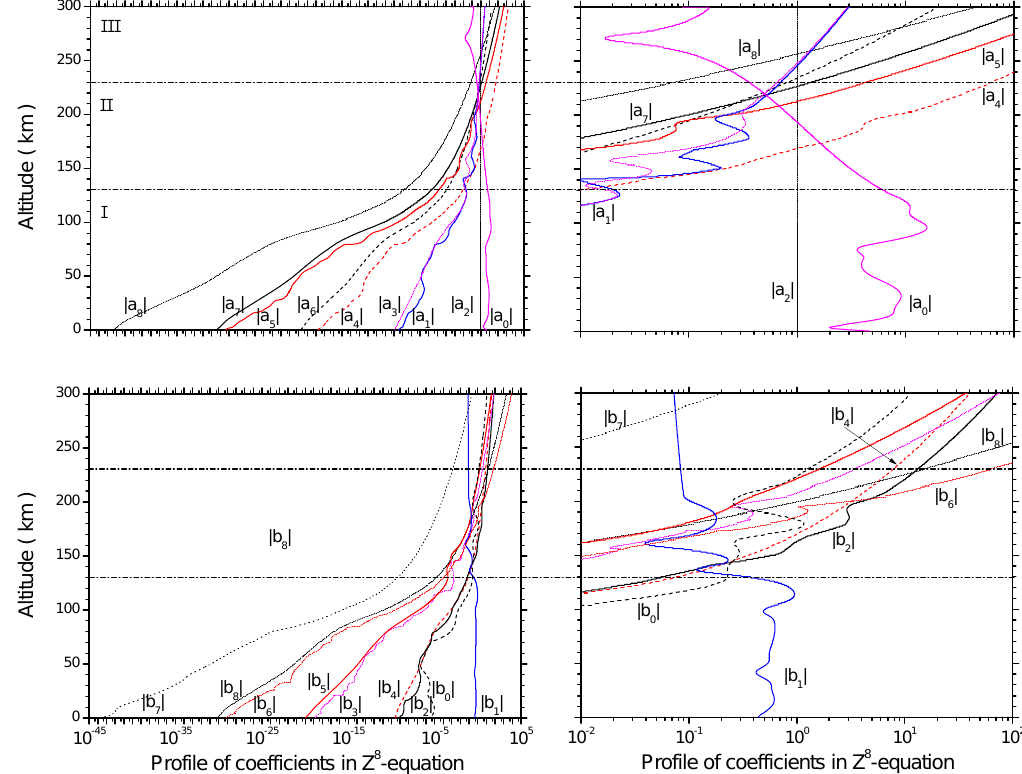
Figure 3. Vertical profiles of coefficients a 0 ∼ a 8 (upper row panels) and b 0 ∼ b 8 (lower row panels). The horizontal axis in the two LHS panels ranges in 10 − 45 ∼ 10 5 , while in the two RHS panels, it is 10 − 2 ∼ 10 2 . Two horizontal lines divide the atmosphere into three vertical layers: adiabatic layer (I: 0–130 km), pumping/damping layer (II: 130–230 km) and viscous layer (III: above 230